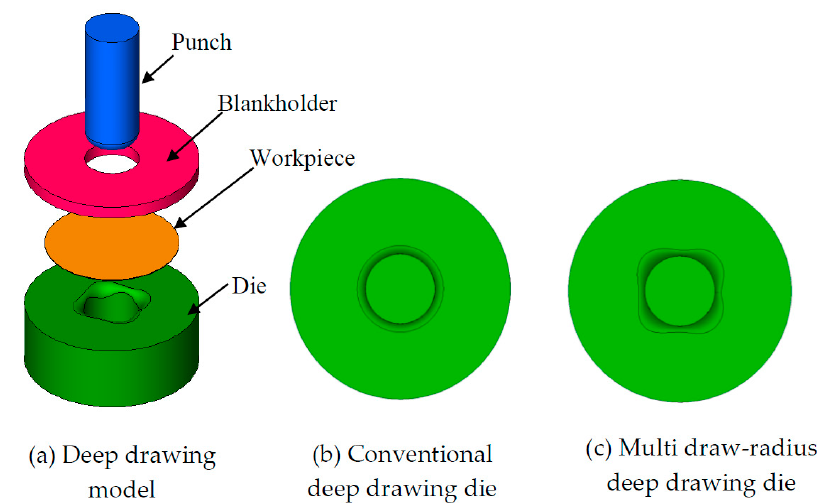
Figure 1. Schematic of deep drawing model and types of deep drawing die: ( a ) Deep drawing model; ( b ) Conventional die; ( c ) Multi draw-radius ( b ) Conventional die; ( c ) Multi draw-radius die.